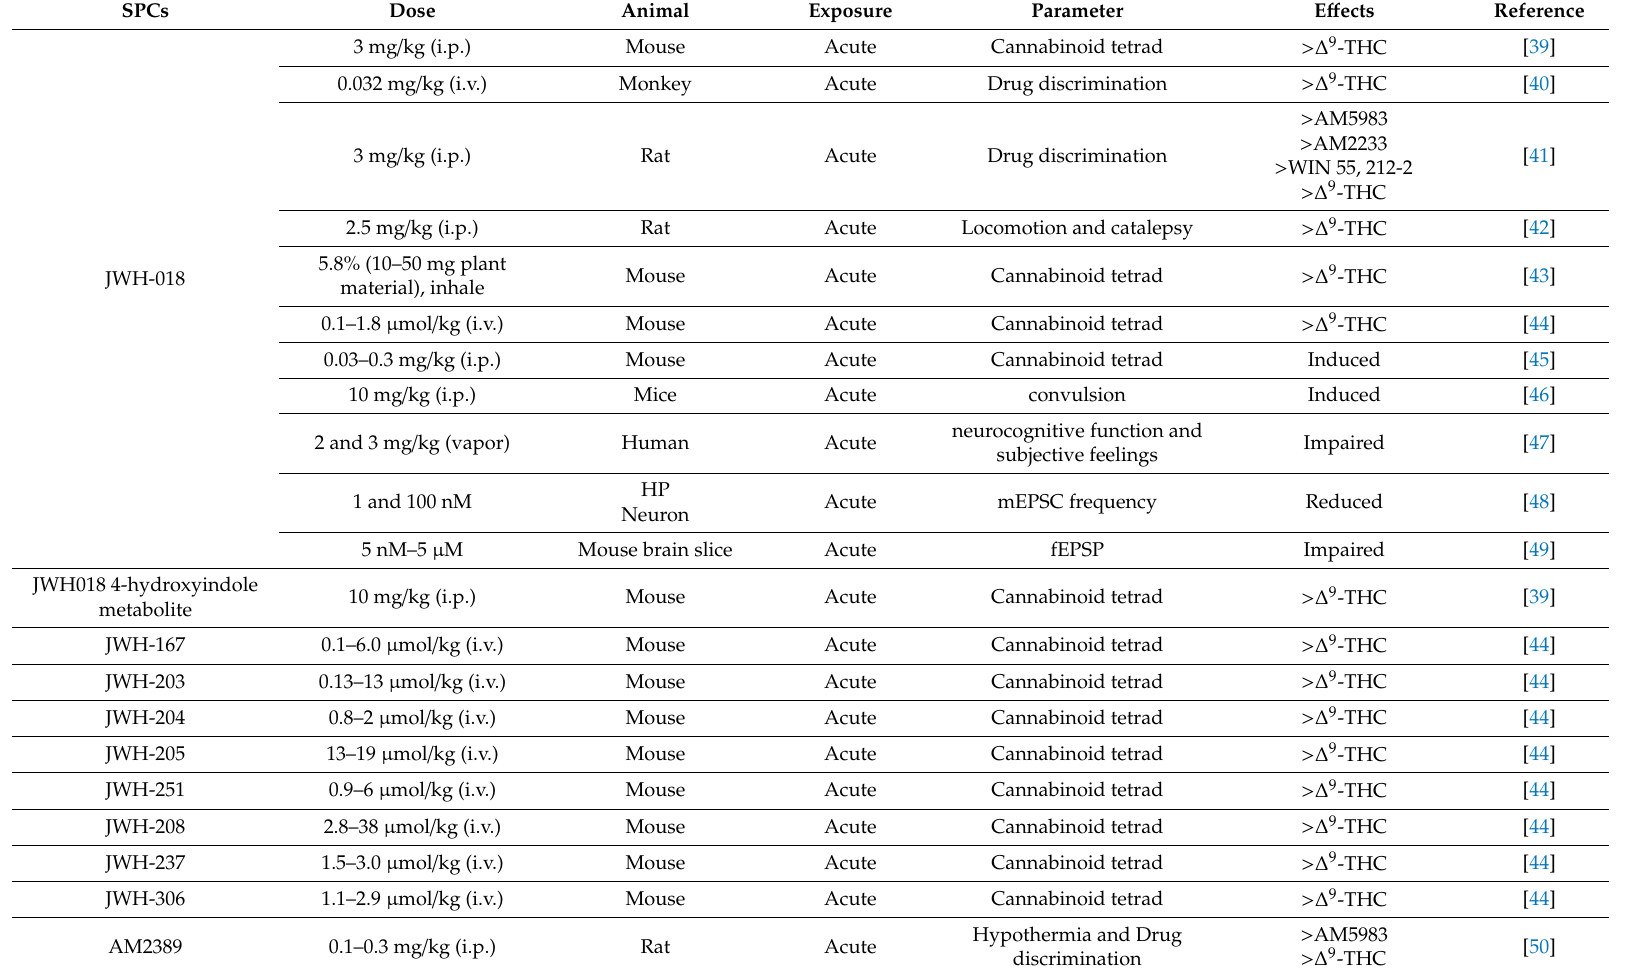
Table 3. E ff ects of SCBs identified in Spice / K